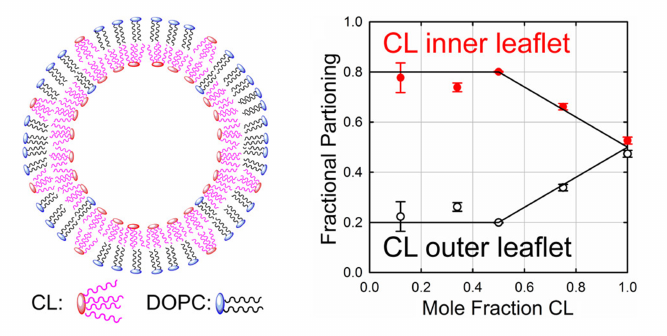
Figure 9. CL asymmetric distribution between the inner and outer leaflet of a LUV. The LUV have a diameter of 100 nm and are made of CL/PC with different CL concentrations. Reproduced with permission from Elmer-Dixon et al. [125], J. Phys. Chem. B; published by the ACS,